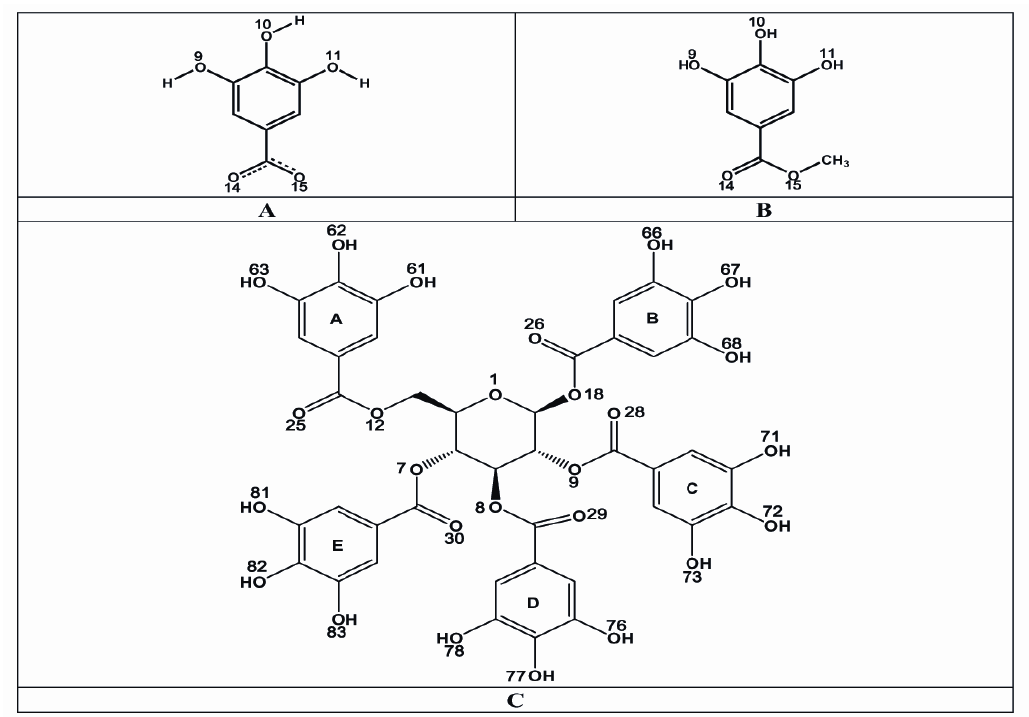
Figure 5. Chemical structures of three major constituents of Thai mango seed kernel extract: GA (A), MG (B) and PGG